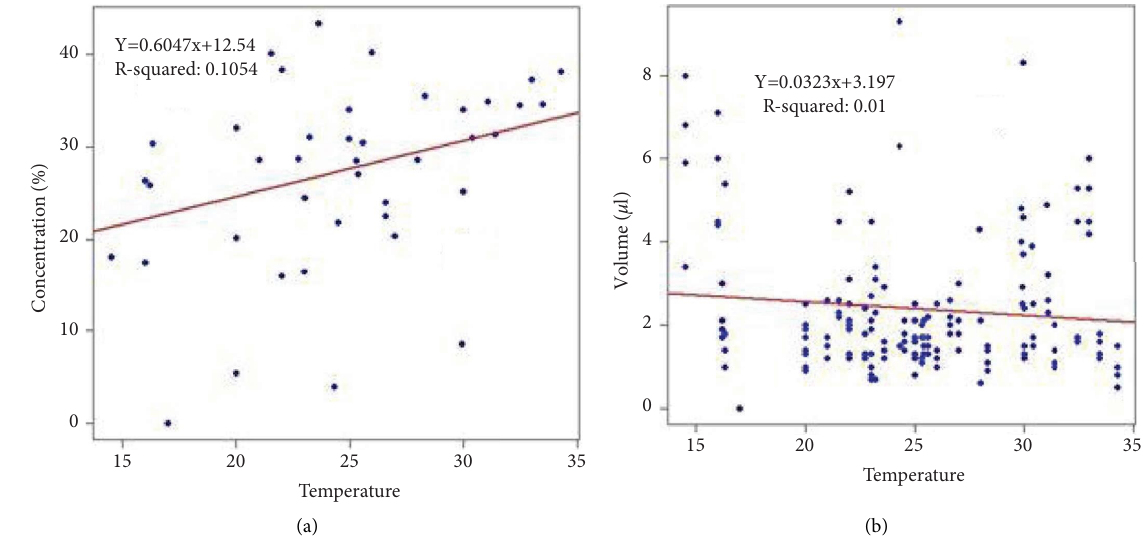
Figure 5: Efects of temperature on nectar concentration (a) and volume (b) of Hygrophila auriculata